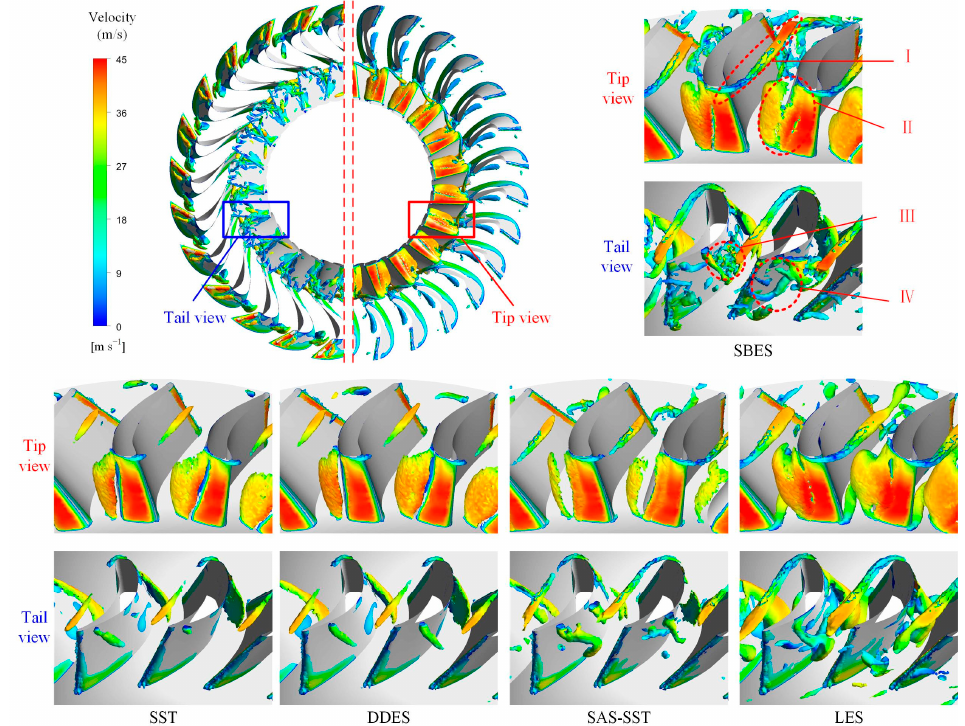
Figure 16. Vortex structure of stator cavitation flow field under various models. (I) PV, (II) WV and SV, (III) dense small vortex concentration, (IV) horseshoe-shaped vortices.